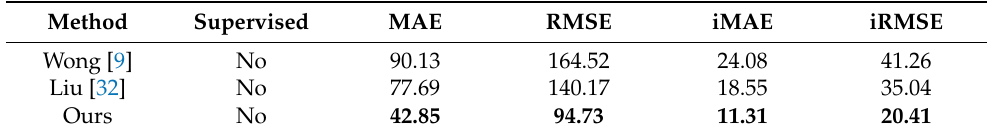
Table 8. Quantitative results of generalization capability on real scenes.